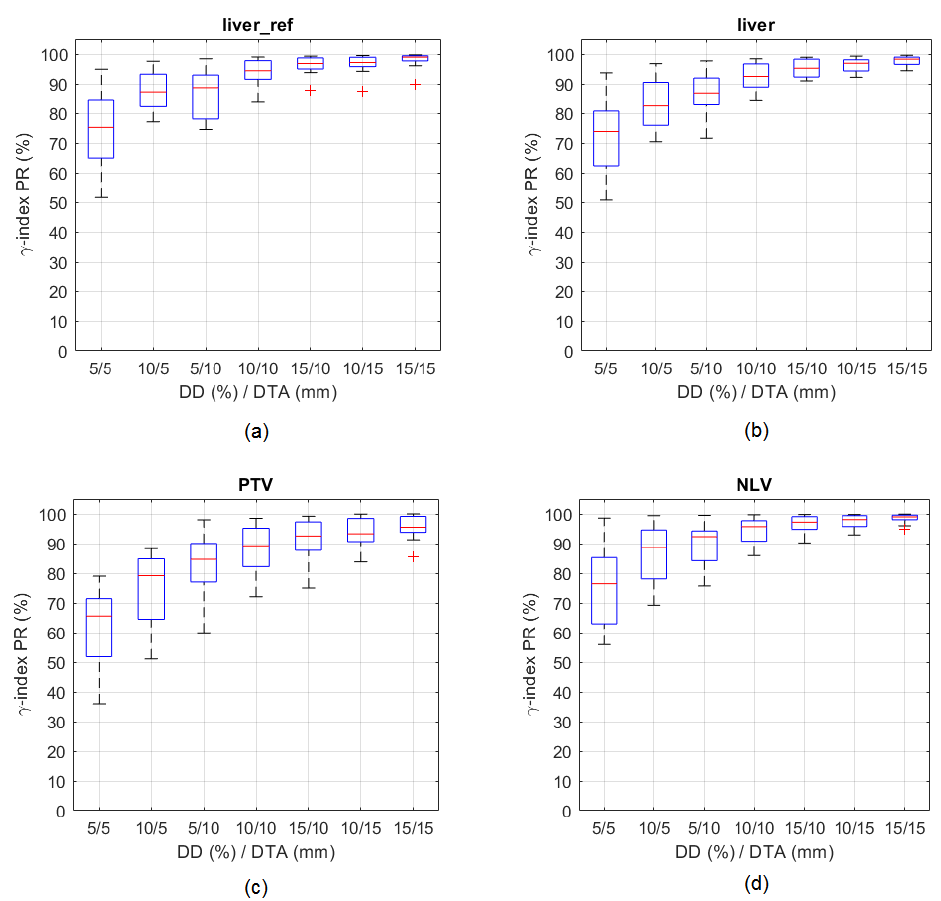
Figure 5. Boxplots with the distributions of the γ -index PR considering seven DD/DTA test conditions in four liver ROI: ( a ) liver_ref , ( b ) liver, ( c ) PTV, and ( d ) NLV. The red plus sign are considered/taken as outliers. Table 4. Administered and estimated optimal activities based on SPECT-MAA and on PET-MS for each of the 11 treatments, with OF converging for a maximum between 0 and 12